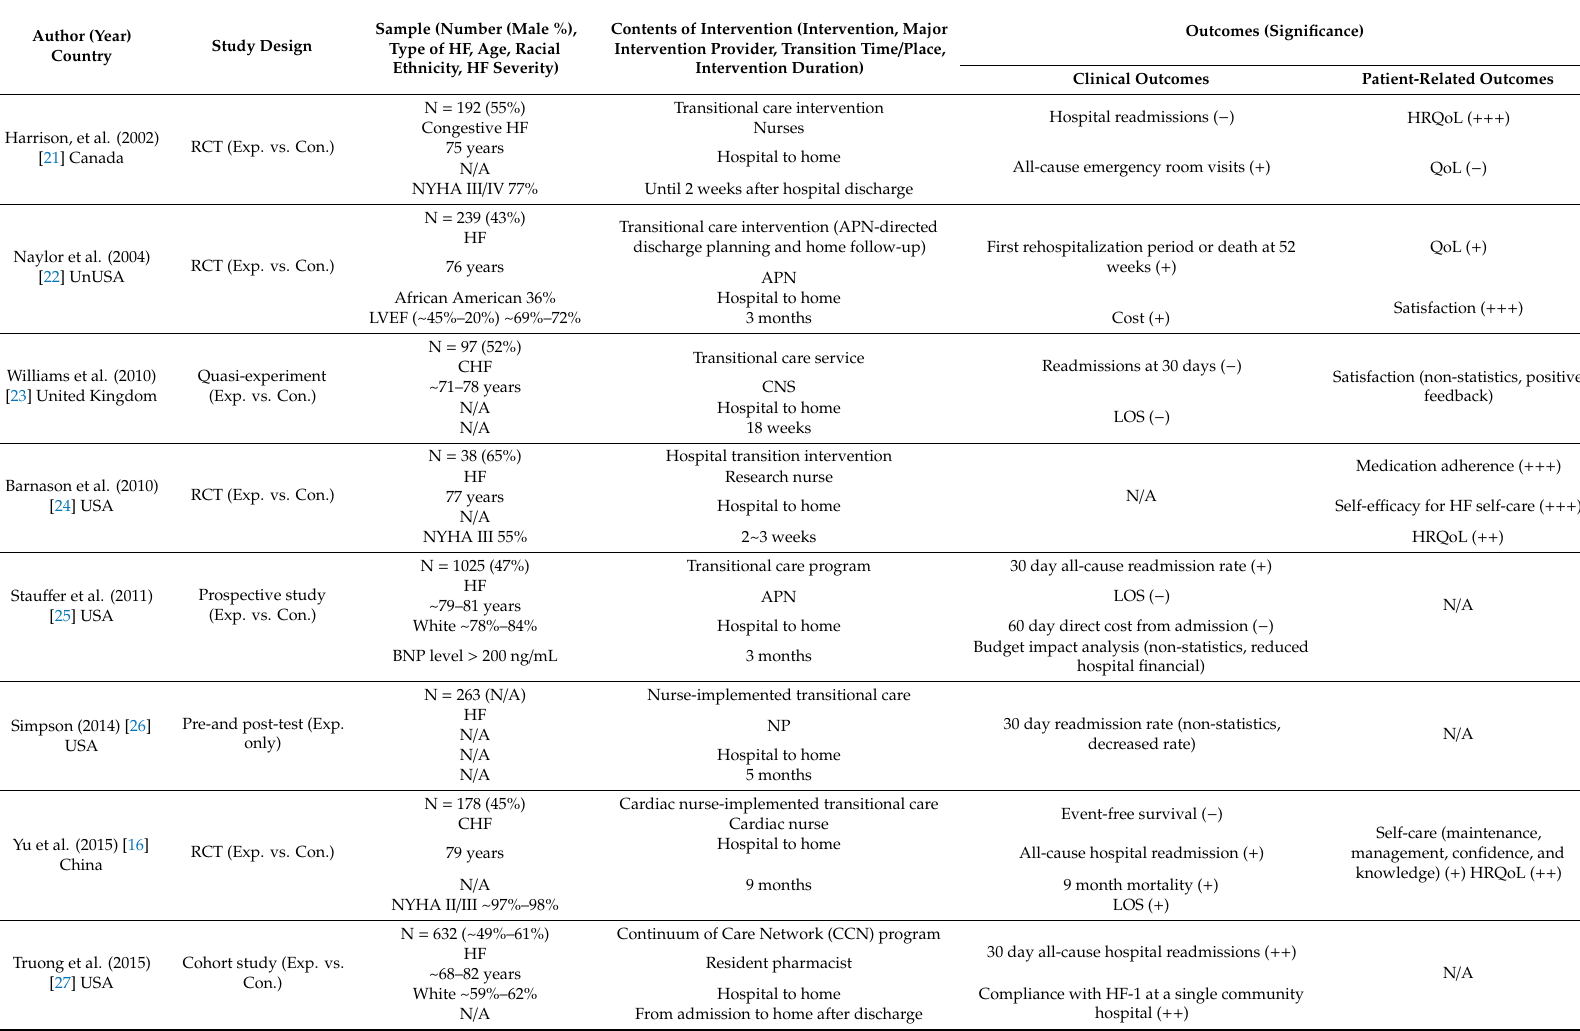
Table 1. Descriptive summary of transitional care intervention studies for patients with HF ( n =